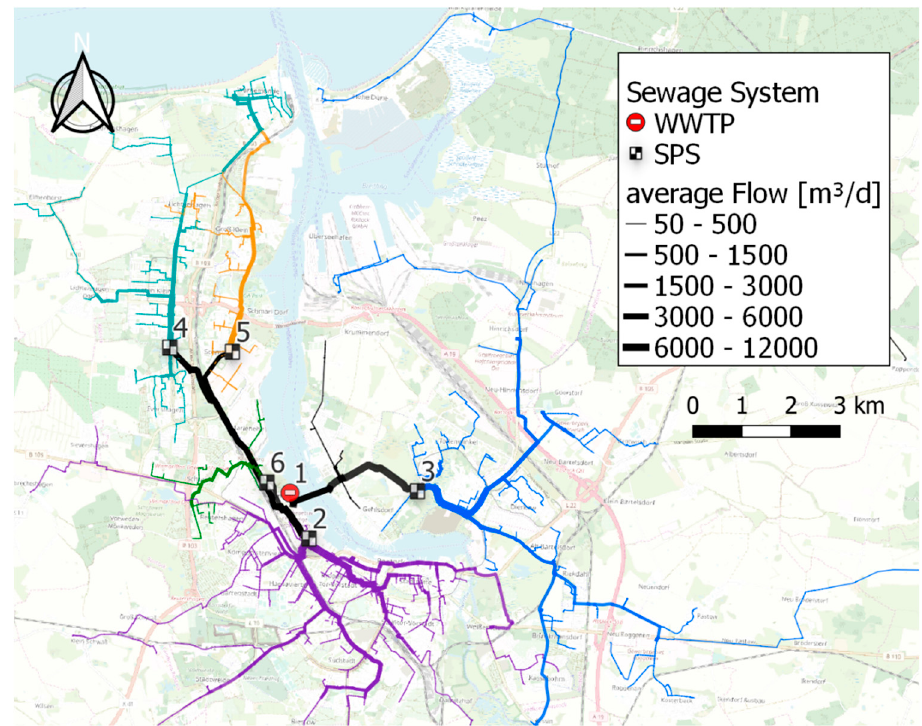
Figure 9. Accumulated flow in the center of Rostock (main pipes; for clarity, only estimated flows > 50 m³/d are shown); colors indicate different catchments of SPSs.